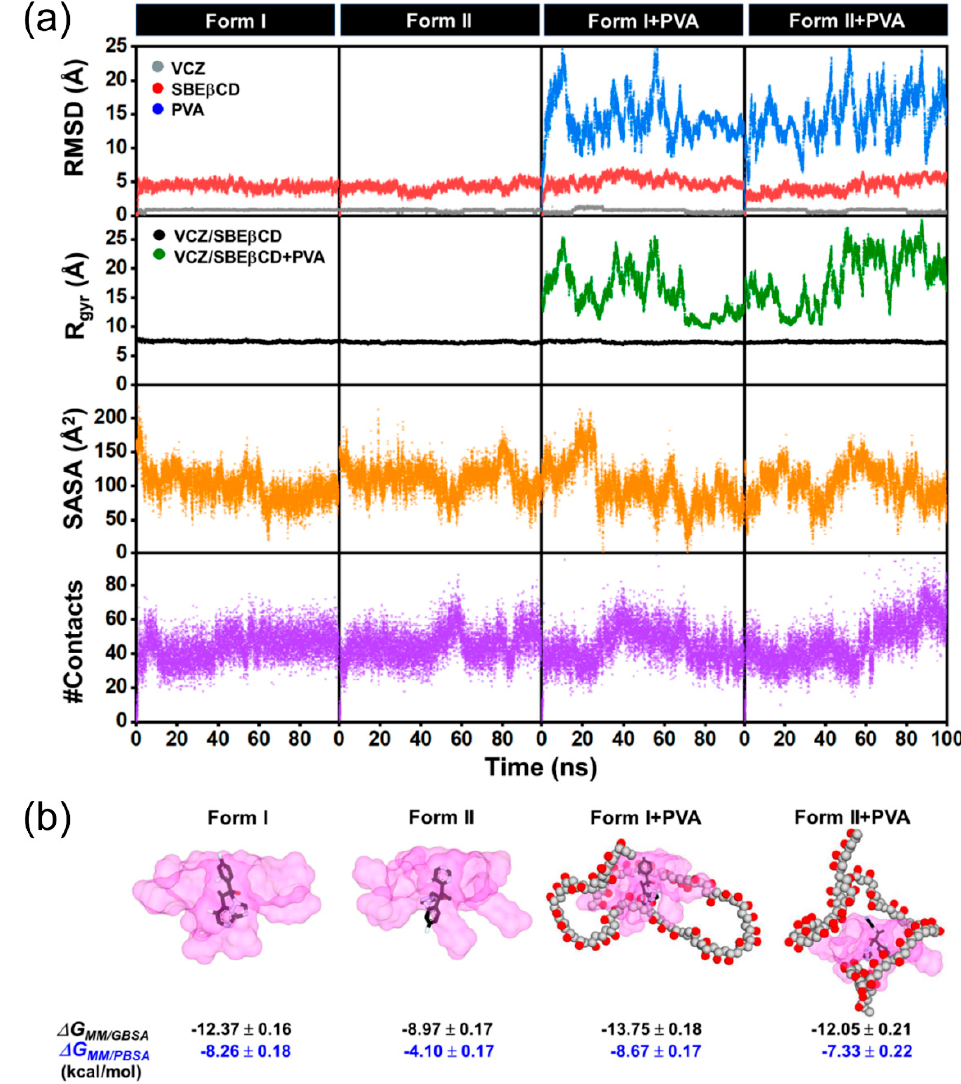
Figure 4. ( a ) RMSD, R gyr , SASA and number of atom contacts of two different forms of the VCZ/SBE β CD and VCZ/SBE β CD/PVA inclusion complexes along the simulation time, ( b ) repre- sentative snapshots of the binding orientation of each system with the average Δ G MM/GBSA and Δ G MM/PBSA in kcal/mol calculated from over the last 20 nanoseconds (ns) simulation time. It was illustrated that PVA could possibly occupy the VCZ/SBE β CD inclusion com- plex. The average MM/GBSA ( Δ G MM/GBSA ) and MM/PBSA ( Δ G MM/PBSA ) binding free energies